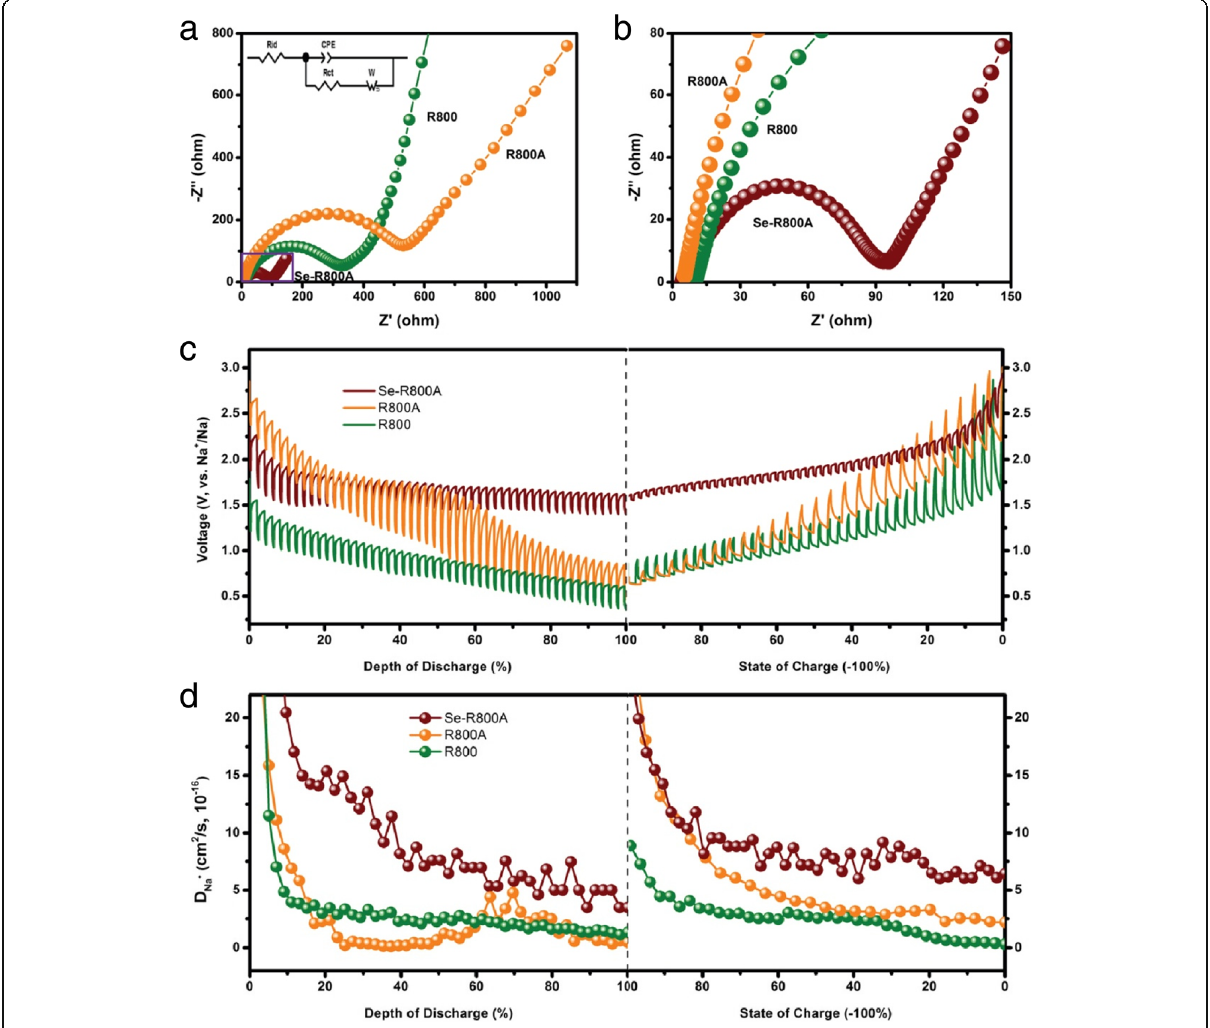
Fig. 6 a Nyquist plots of Na-Se batteries assembled with the R800, R800A, and Se-R800A as cathodes for impedance analysis and the inset is the equivalent circuit. b Magnified the section of the Se-R800A. c Voltage profiles and d the Na + diffusion coefficients of the R800, R800A, and Se-R800A obtained via the GITT technique during discharge/charge processes